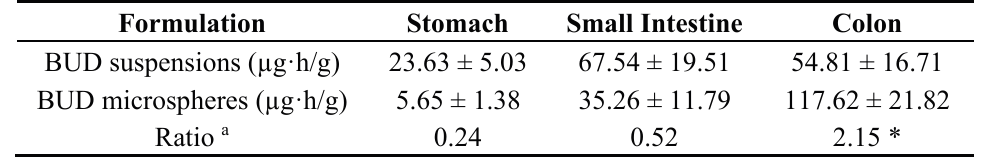
Table 2. The AUC 0–24 h of BUD in stomach, small intestine and colon after intragastric administration of suspensions and microspheres to rats ( n = 5).